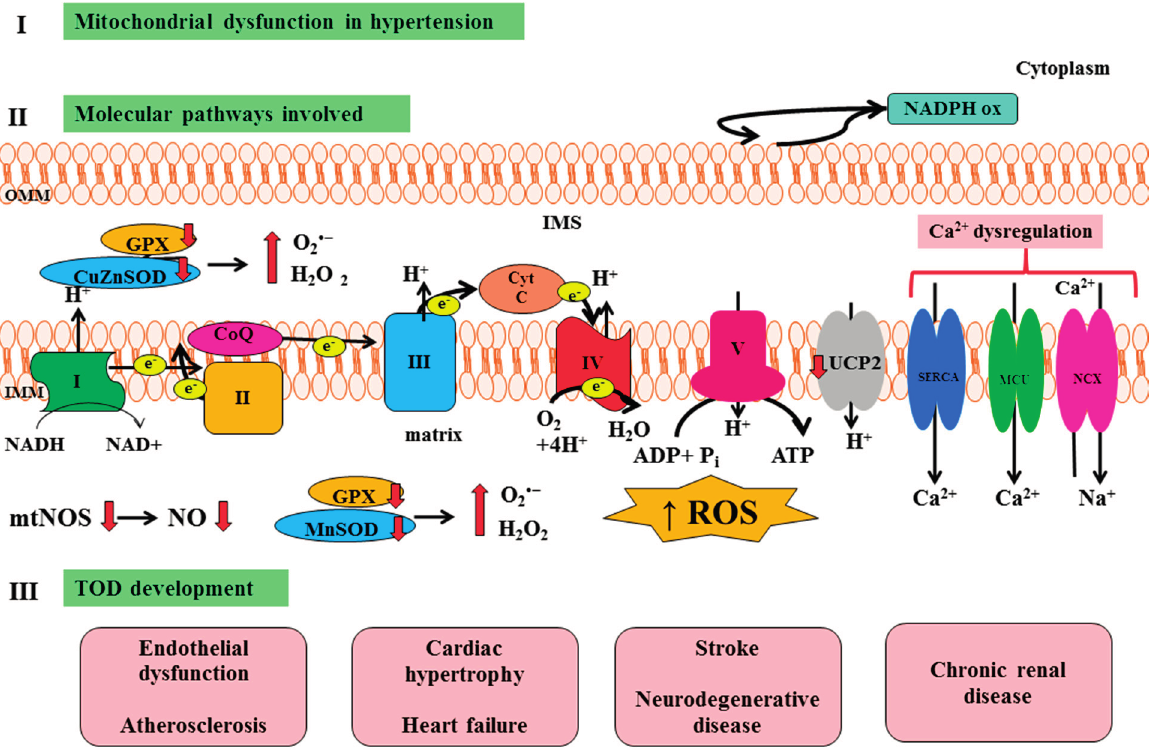
Figure 1. Representation of main molecular pathways linking mitochondrial dysfunction with TOD development in hypertension. NAD: Nicotinamide adenine